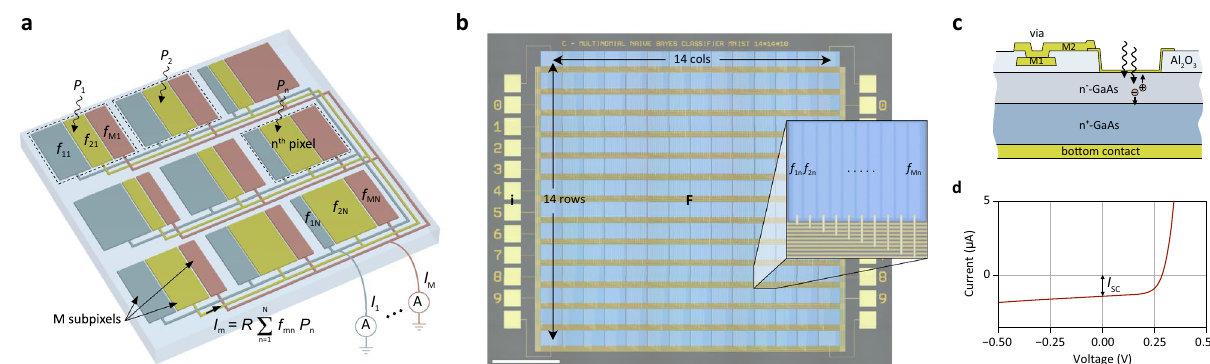
Figure 2. Photosensor implementation. ( a ) Schematic illustration of the photosensor. Each pixel is divided into subpixels, with fill factors f mn , that are connected together to form M superpixels whose output currents I m are measured. ( b ) Microscope image of a NB classifier for MNIST classification with N = 14 × 14 pixels and M = 10 output channels. Scale bar, 500 μm. Inset: microscope image of the n -th pixel showing M subpixels. ( c ) Cross section of a GaAs Schottky photodiode with two metal layers for routing of the electrical signals. The band diagram is presented in Supplementary Figure S1. ( d ) Current–voltage characteristic for one of the detector elements under optical illumination. I SC is the short-circuit